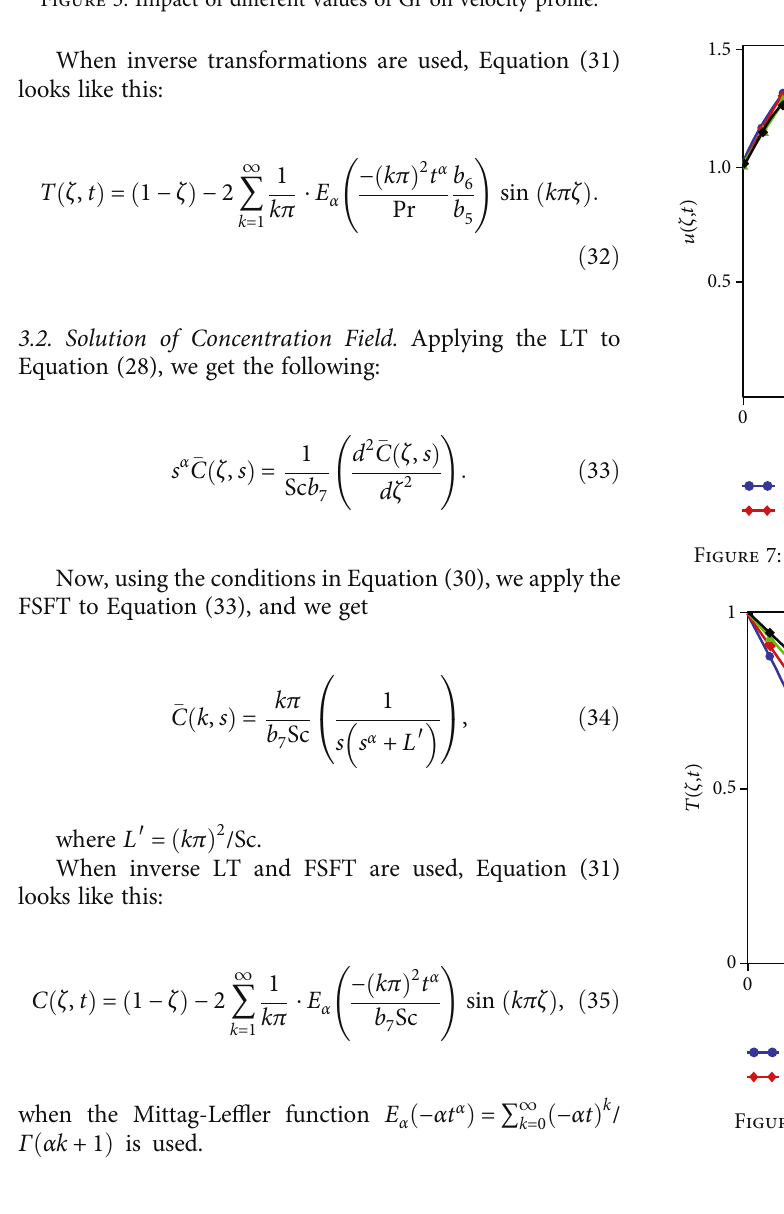
Figure 5: Impact of di ff erent values of Gr on velocity pro fi le. Figure 6: Impact of di ff erent values of Gm on velocity pro fi le.